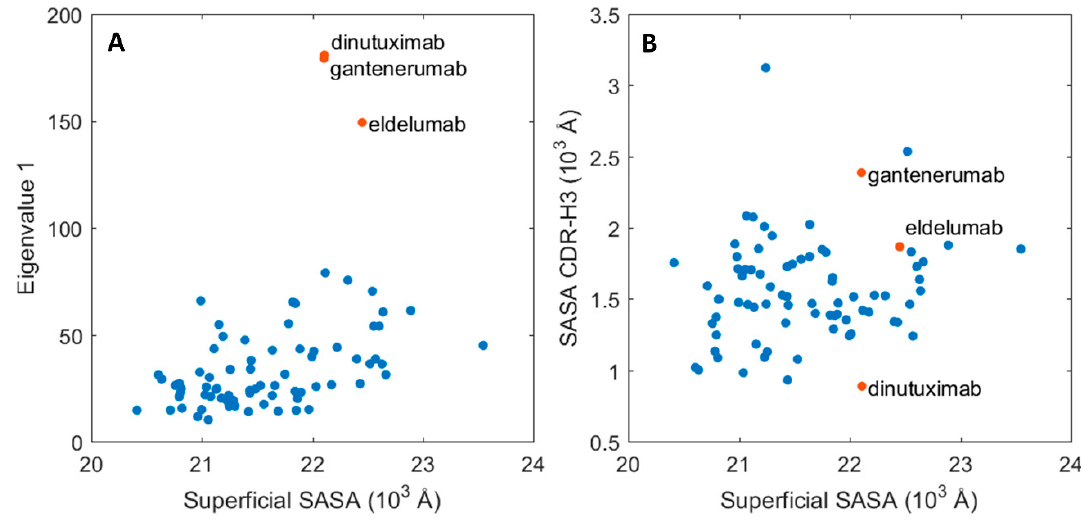
Figure 4. Essential molecular motions of the mAbs and their respective SASA. ( A ) Magnitude of the principal motion in function of the protein superficial SASA. ( B ) CDR-H3 SASA in function of the whole protein SASA. The values for three outliers: dinutuximab, eldelumab, and gantenerumab are depicted in red.